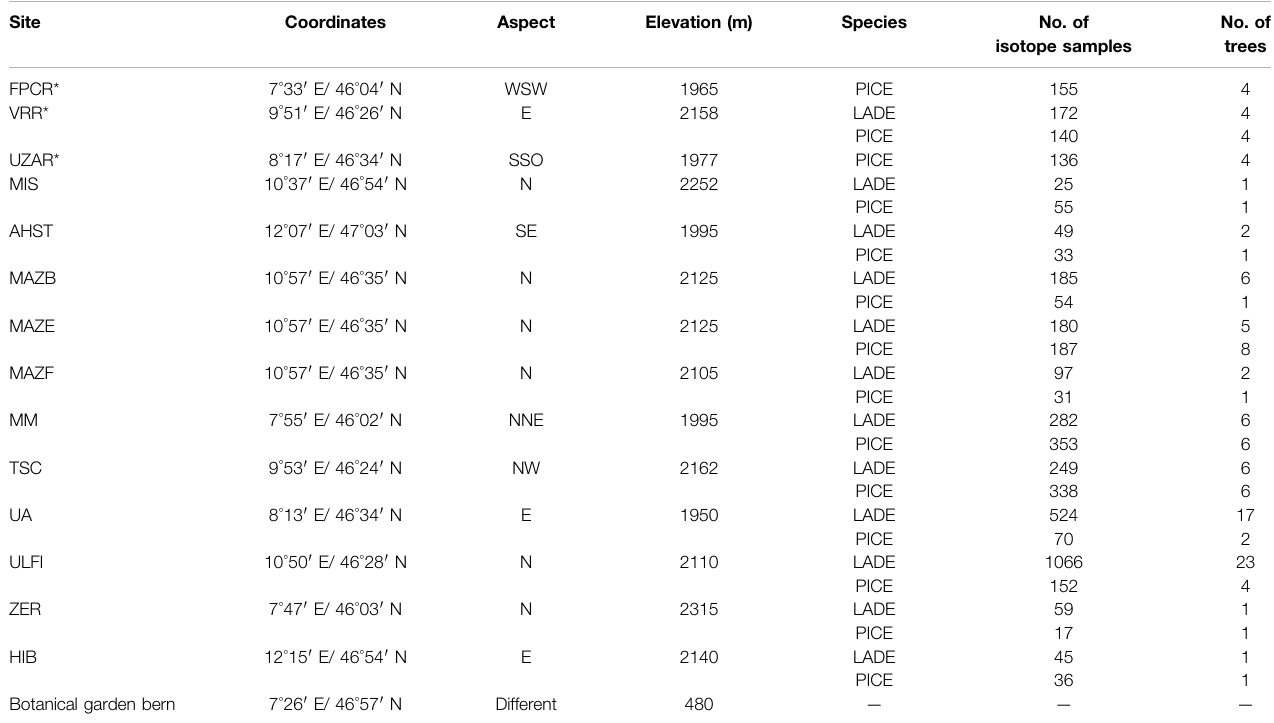
TABLE 1 | Characteristics of the 12-sampling sites, number of trees and samples (each sample constitutes of a block of 5 years). Specie code: larch: LADE, cembran pine: PICE, spruce: PCAB. Site Coordinates